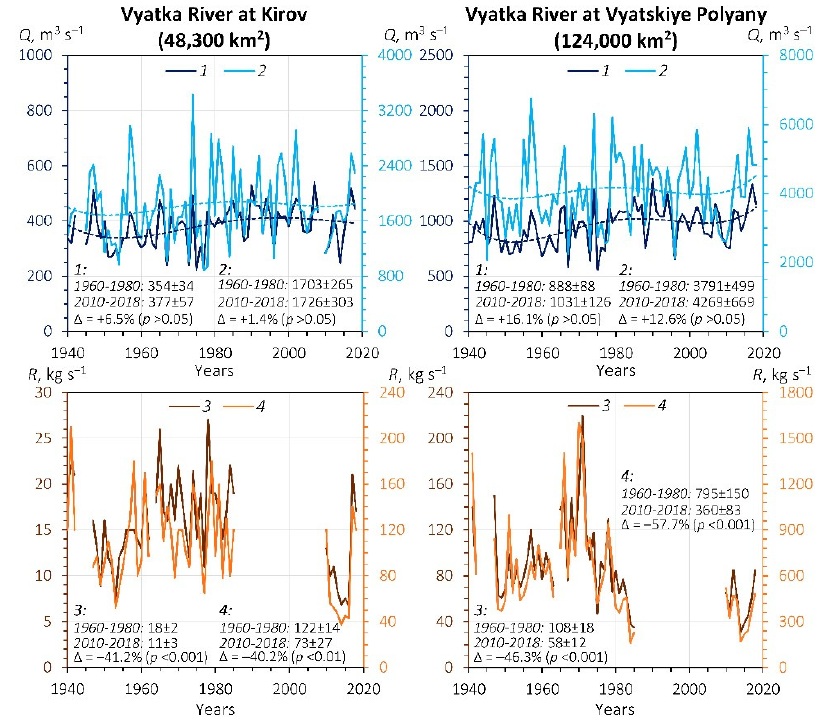
Figure 7. Changes in water discharge ( Q ) and suspended sediment load ( R ) of the Vyatka River (the forest zone’s south, see Figure 2B and Table 1) during 1940–2018. 1 –mean annual Q ; 2 –maximum (per annum) mean monthly Q ; 3 –mean annual R ; 4 –maximum (per annum) mean monthly R ; the dashed line–a fourth-degree polynomial trend; ∆ –relative changes with p (Student’s t -test).